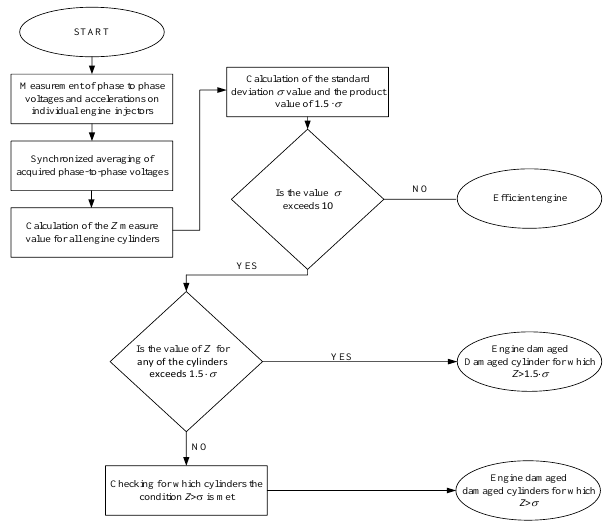
Fig. 12. An algorithm for assessment of technical condition of engine driving synchronous generator based on the phase-to-phase